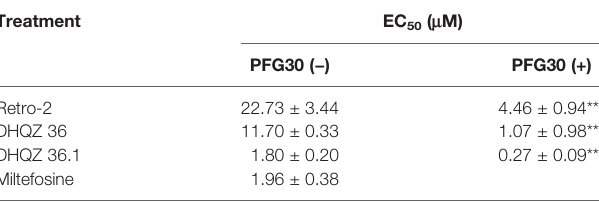
TABLE 1 | Estimation of the ef fi cacy of PFG30 encapsulated DHQZ analogs on L. donovani infections. Treatment